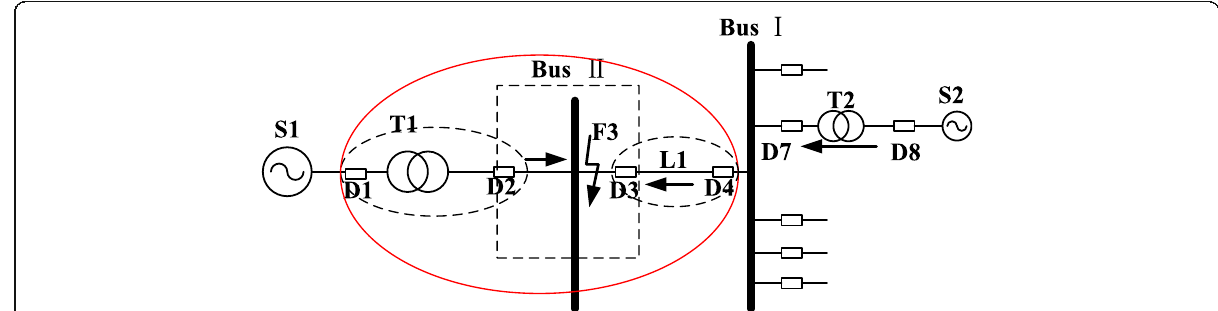
Fig. 7.2 L1 is included in EBDP II 100 ms after the fault in